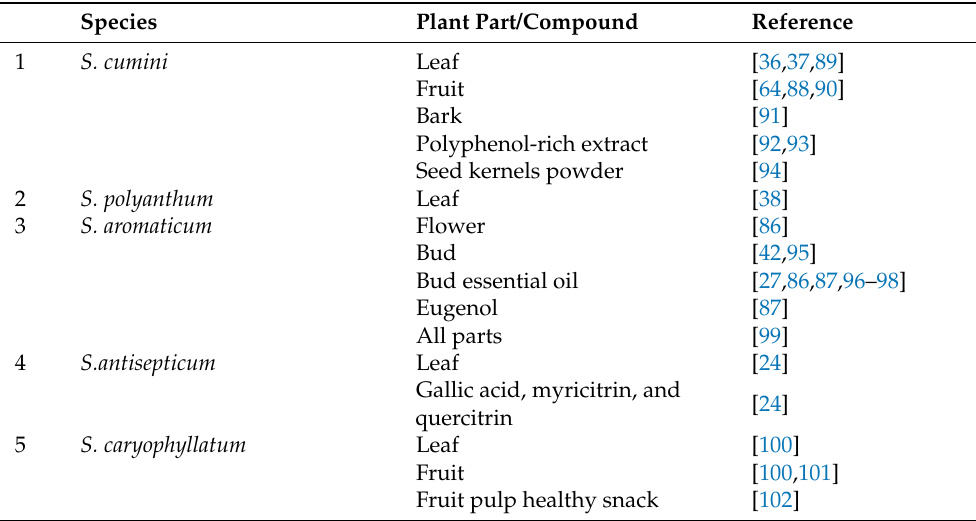
Table 3. Summary of plant parts or compounds examined for antioxidant activity from Syzygium